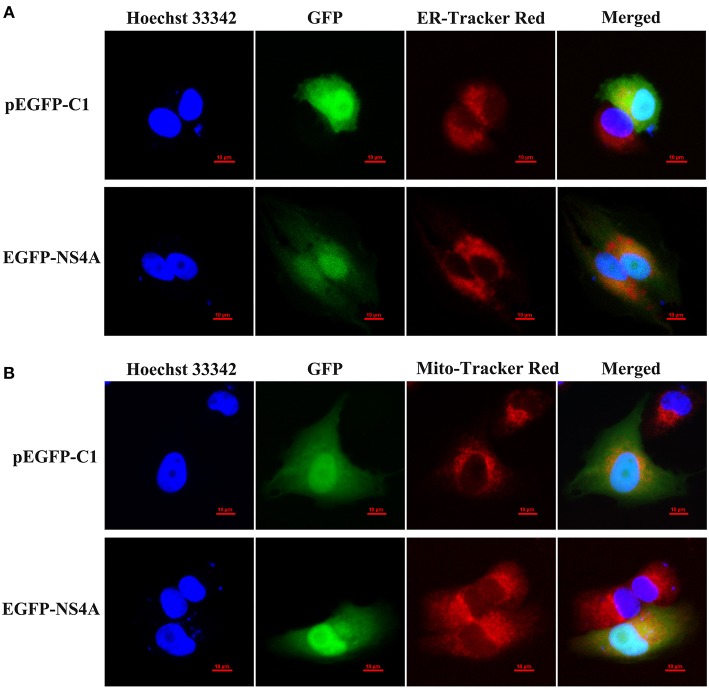
Subcellular localization of EGFP-NS4A fusion protein in SUVECs. The EGFP-NS4A fusion protein subcellular localization was detected by confocal microscopy. All cells were stained with Hoechst 33342 and ER-Tracker Red (A) or Mito-Tracker Red (B). Scale bar = 10 μm. The location of intracellular ER is indicated by ER-Tracker Red and shows red fluorescent. The location of intracellular mitochondria is indicated by Mito-Tracker Red and shows red fluorescent. The location of cell nucleus is indicated by Hoechst 33342 and shows blue fluorescent.